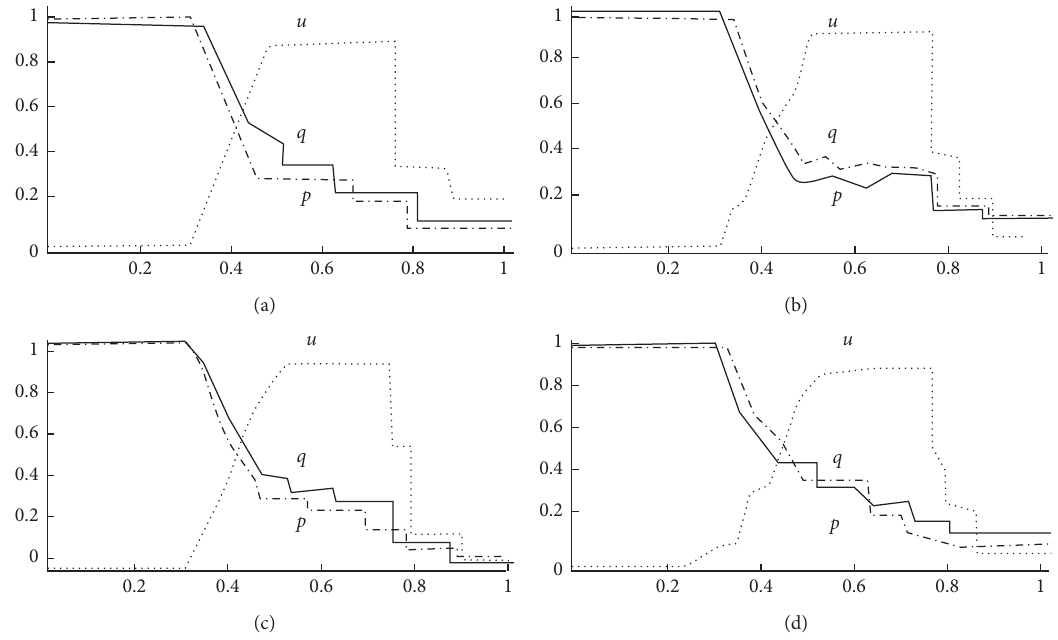
Figure 3: Sod’s Riemann problem. (a) N � 400, the numerical results of the nonconservative ideal fluid dynamics equation in GRP form (4) are solved by nonconservative ideal fluid dynamics. (b) N � 400, Method 1 is the numerical result of solving nonconservative ideal hy- drodynamic equations in the GRP form. (c) N � 400, the traditional algorithm solves the numerical results of the nonconservative ideal fluid mechanics equations in the GRP form. (d) N � 1200, numerical results of nonconservative ideal hydrodynamic equations in the GRP